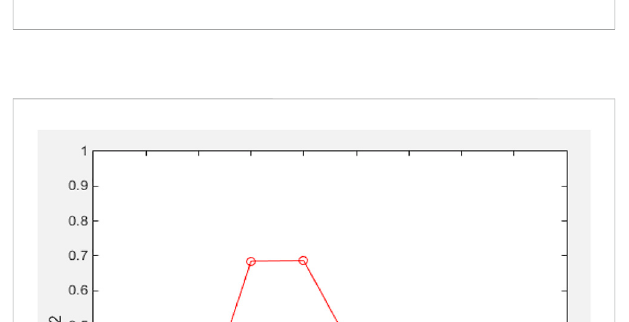
FIGURE 4 In fl uence of spread value on the performance of newrb radial basis function network.